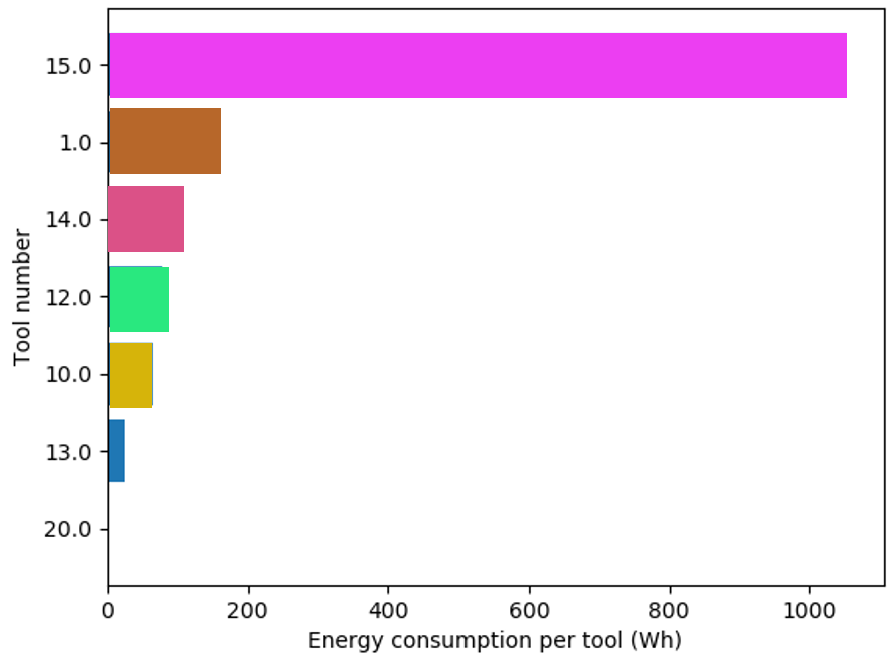
Figure 5. Energy consumption per tool.